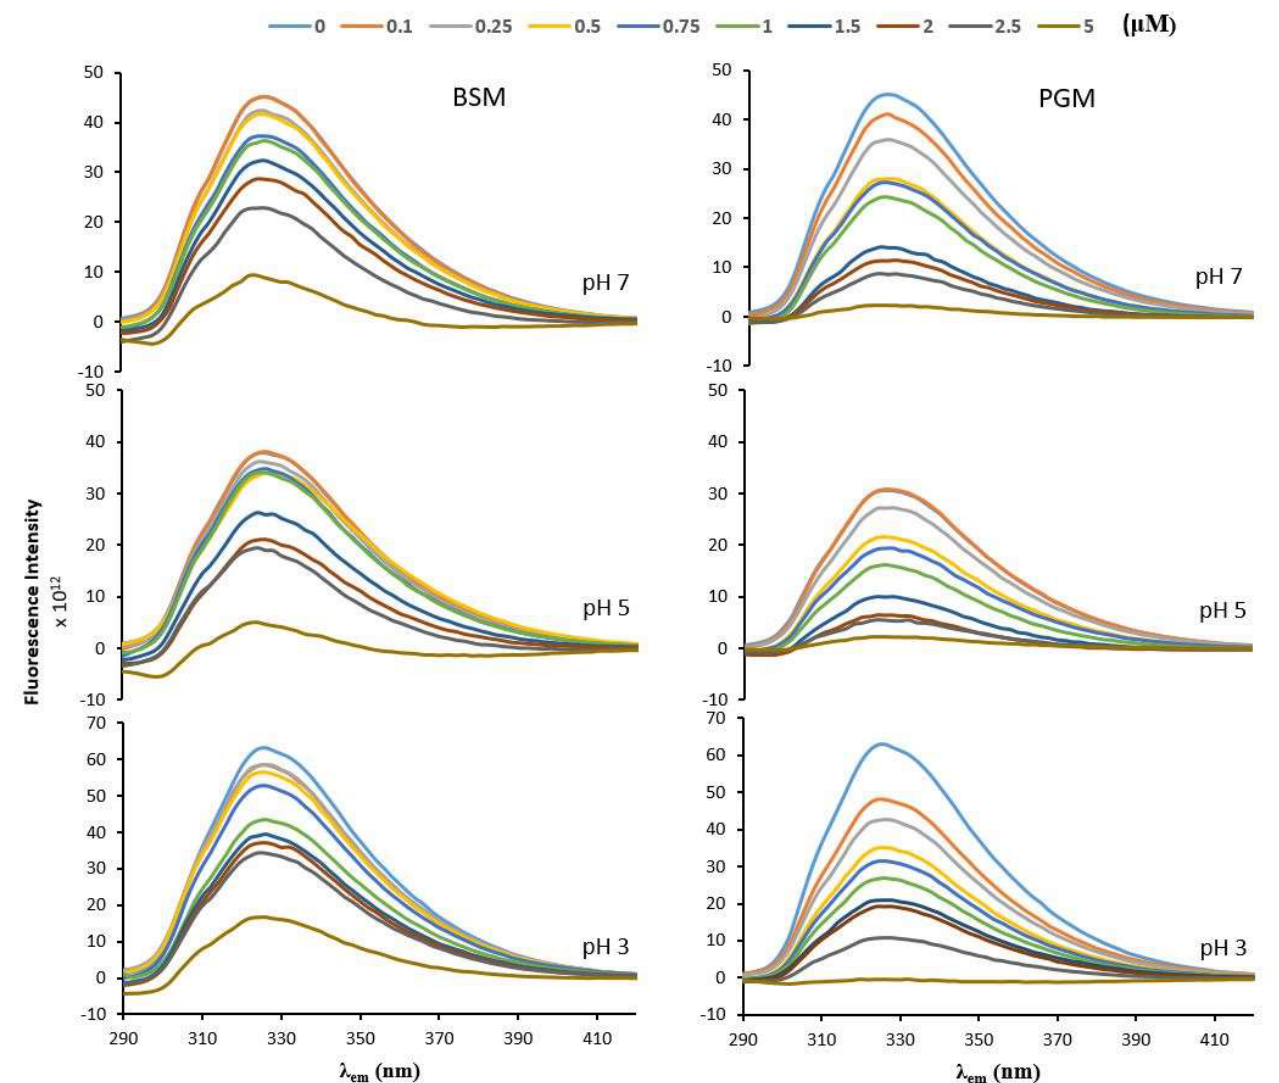
Figure 2. Fluorescence emission spectra (at λ ex 280 nm) of β-lactoglobulin (28 μM) in the presence of increasing concentration of bovine submaxillary mucin (BSM) and porcine gastric mucin (PGM) in phosphate buffer solution with different pH values (pH 7, pH 5, pH 3). Each curve represents a triplicate assay after correction for mucin fluorescence.